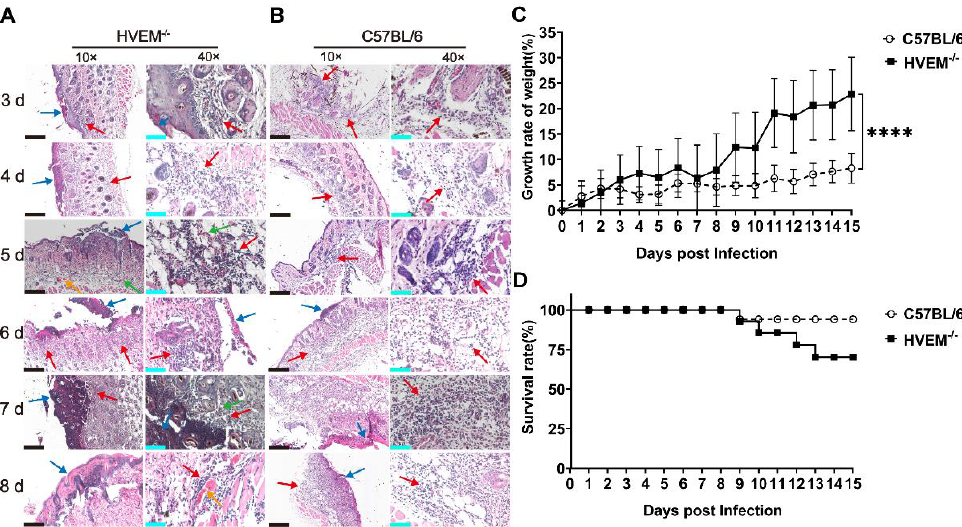
Figure 4. Clinical manifestations of HSV-1-infected C57BL/6 and HVEM − / − mice. Pathological changes in the epithelial tissue of ( A ) HVEM − / − and ( B ) C57BL/6 mice within 1–10 days of infection with HSV-1. Inflammatory cell infiltration and tissue necrosis are indicated with red and blue arrows, respectively, and tissue hyperemia and tissue bleeding are indicated with yellow and green arrows, respectively ( n = 3 per time point in each group). The black scale bar is 200 µ m, and the cyan scale bar is 50 µ m. ( C ) Increase in weight and ( D ) the survival rate of C57BL/6 (circle) and HVEM − / − (square) mice infected with HSV-1 ( n = 12/group) during the 15-day observation period. Statistical significance was